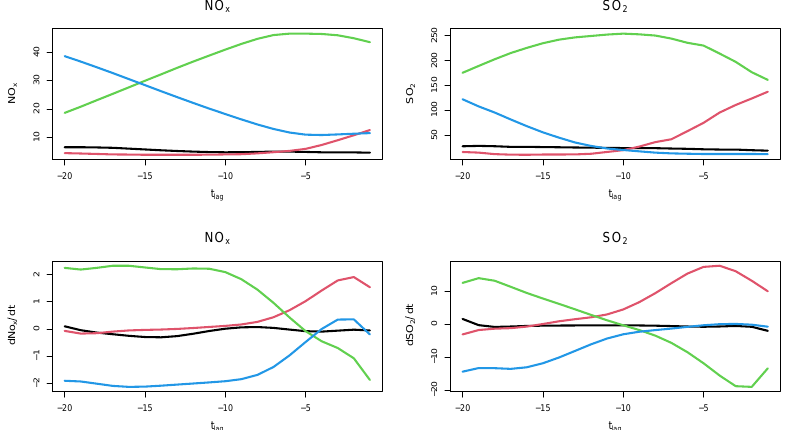
Figure 1. Five curves of the historical matrix for pollutants ( NO ( t ) ,SO ( t ) ) and their corresponding first derivatives ( NO (cid:48) ( t ) ,SO (cid:48) ( t )) , observed in a period of time t lag = 20.